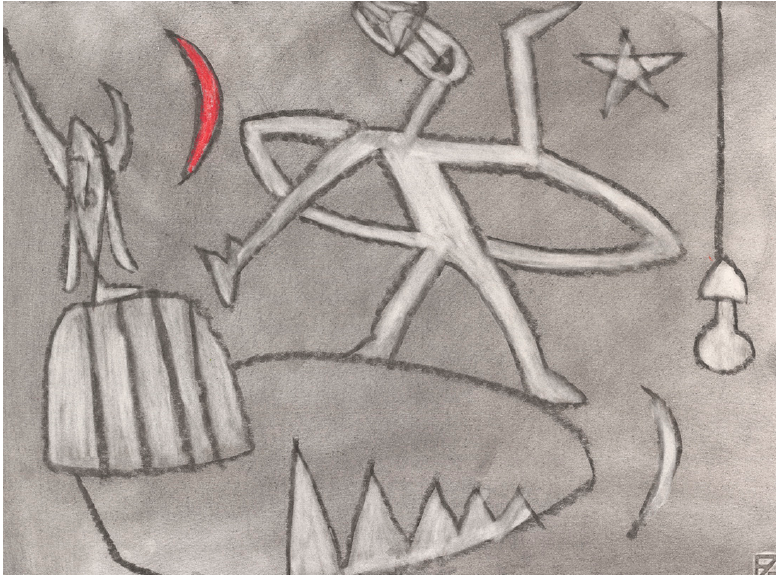
Figure 9. Gianpaolo (aged 29, depressive disorder and drug abuse) Discussions, Conversations, Reasoning, at the End Everything Returns to the Same Point